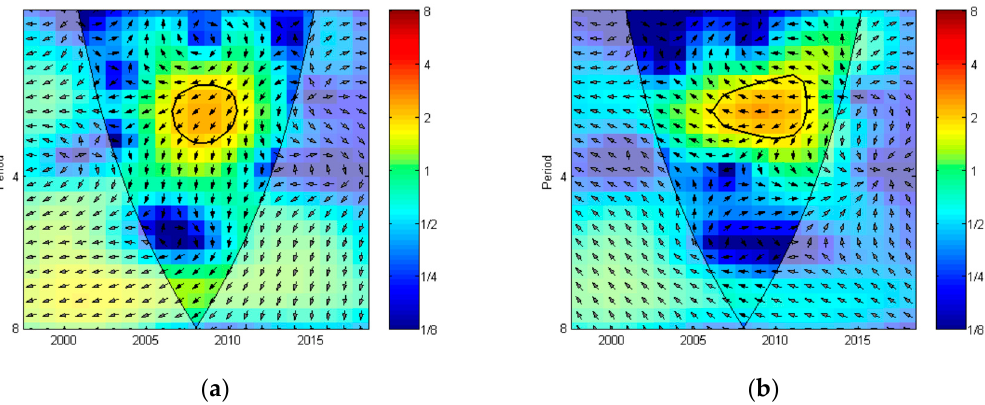
Figure 8. the cross ‐ wavelet spectrum of TS1 of the 5 ‐ month and 1 ‐ month lagged UIEP against Niño3.4 ( a ) and SOI ( b ). The thin black line represents the cone of influence. The thick enclosed areas denote the 5% significance level using red noise model based on Monte Carlo simulation method. Arrows signify the phase difference of oscillation. The arrow → means the in ‐ phase relationship between the UIEP and climate anomalies, and ← means the anti ‐ phase. The arrow ↓ means climate anomalies leading UIEP by 90°, and vice versa.